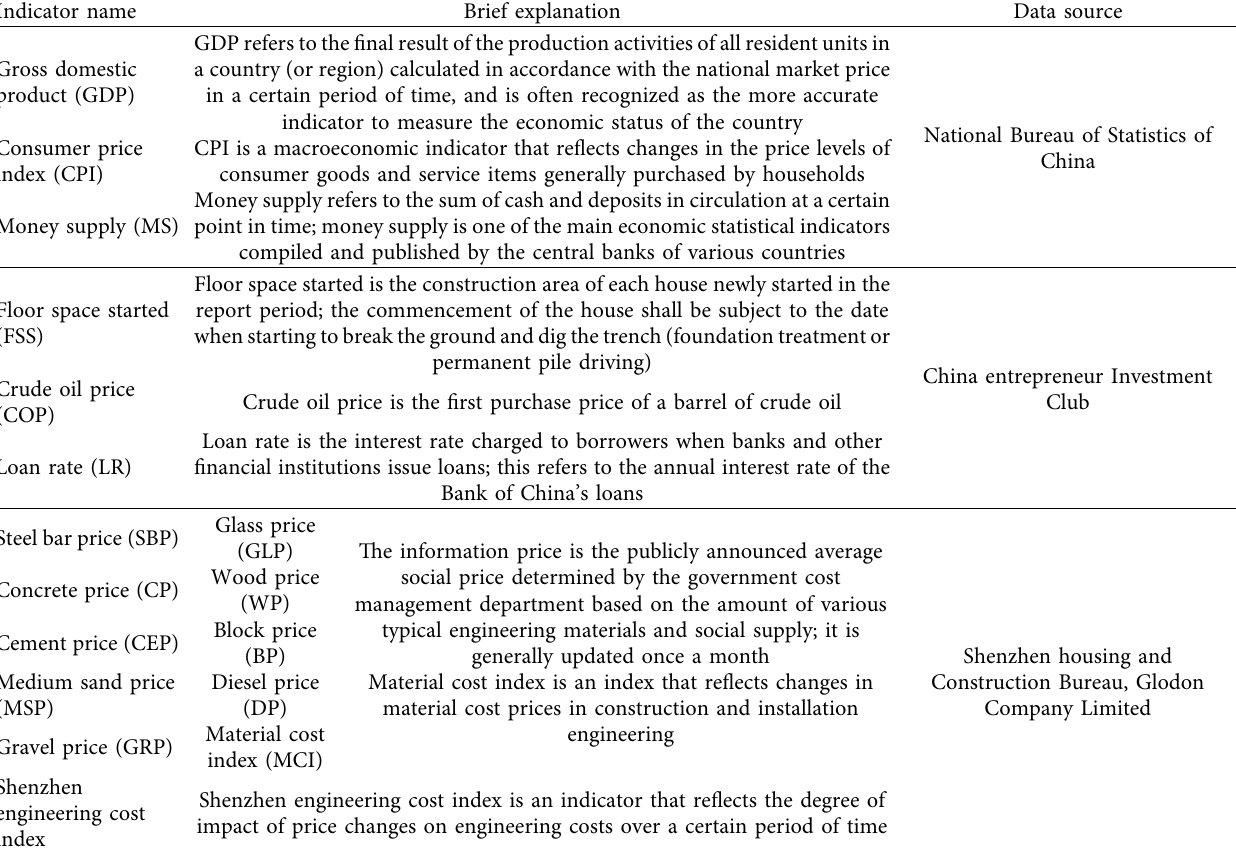
Table 1: Coding, type, and data sources of the index